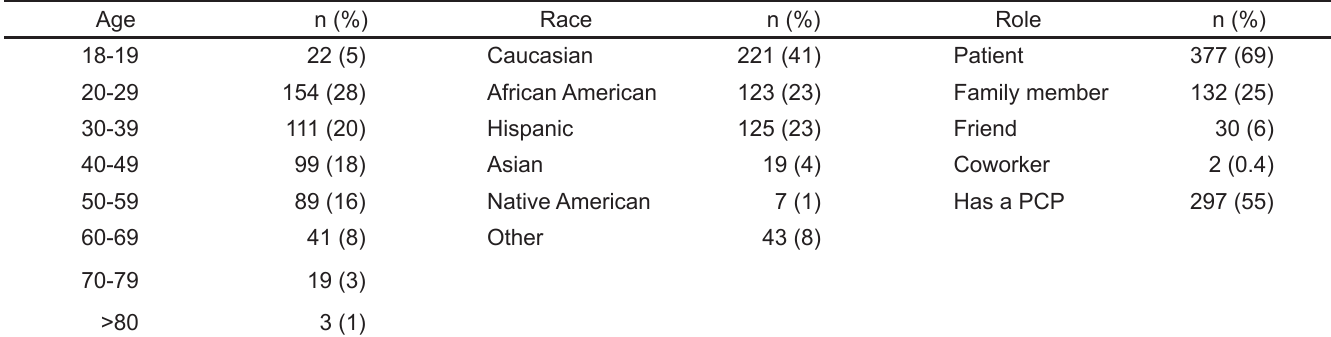
Table 1. Demographics of respondents surveyed.